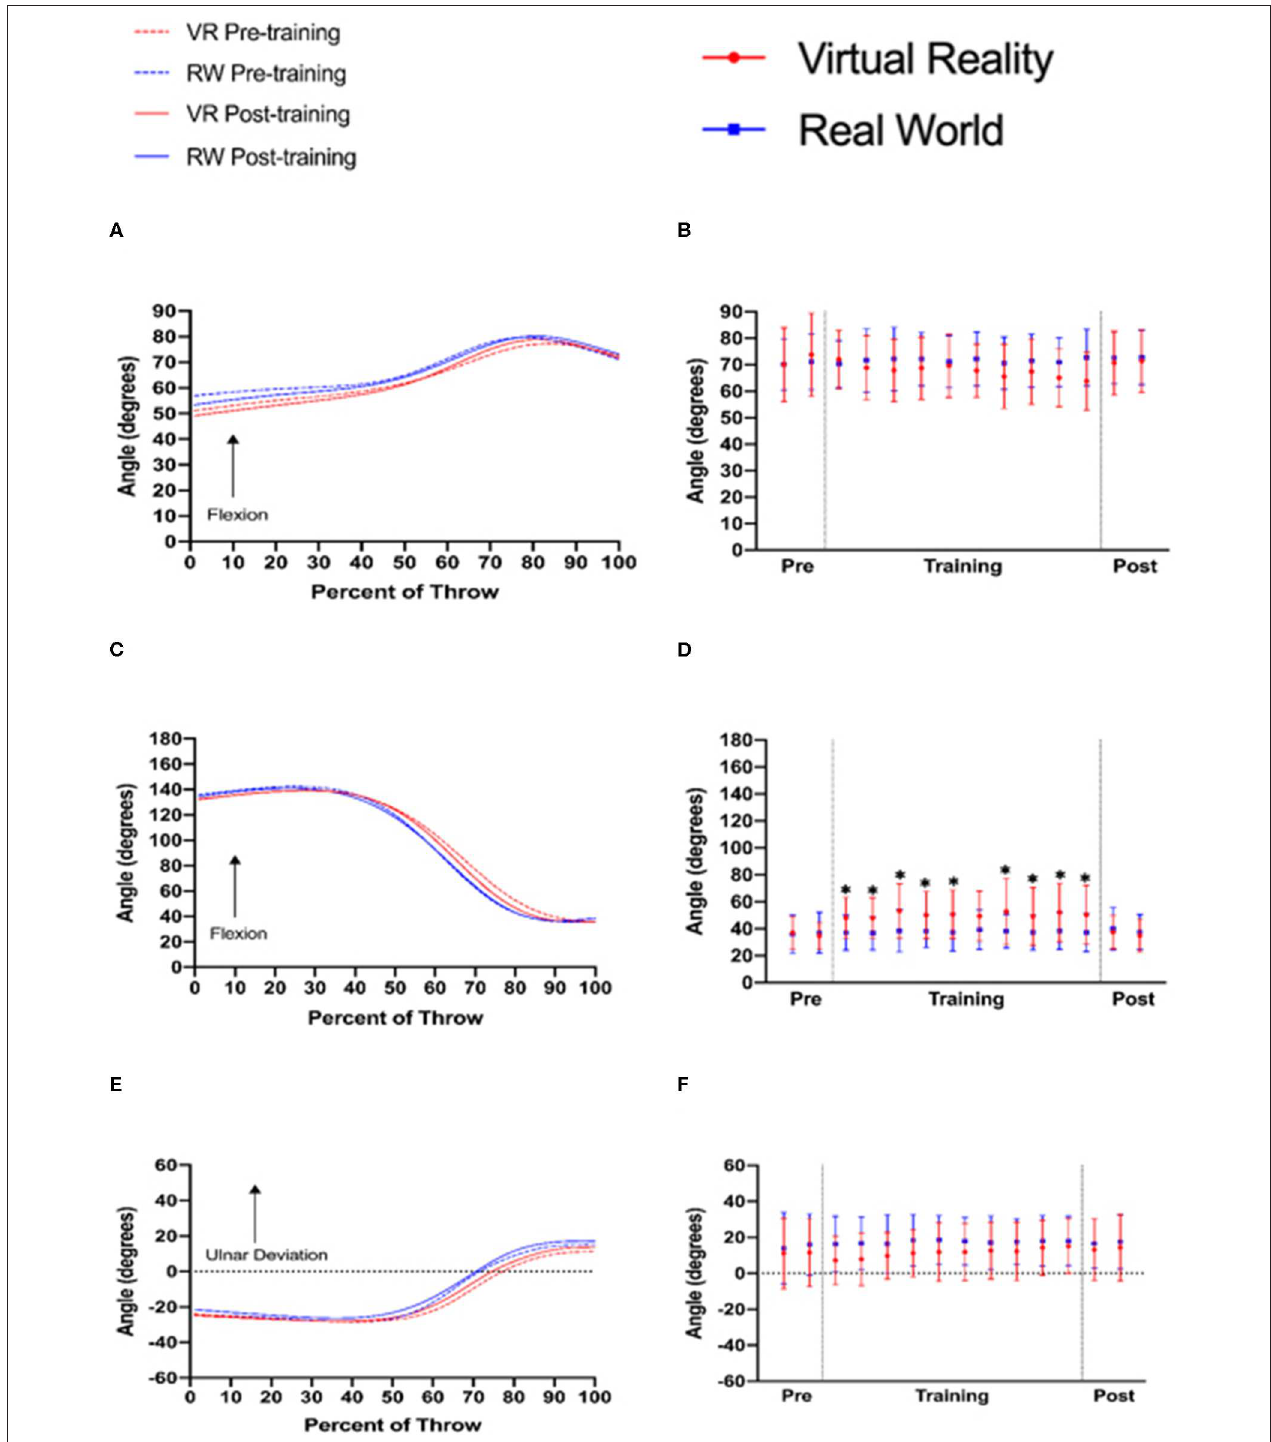
FIGURE 5 | Ensemble curves representing mean joint excursions from start (0%) to finish (100%) of the dart throw (left column) and discrete joint angles (right column) at the time of dart release for participants in the virtual reality and real-world practice groups before (pre) and after (post) training. (A,B) —Shoulder flexion/extension, (C,D) —elbow flexion/extension, and (E,F) —wrist radial/ulnar deviation (* denotes p < 0.05).